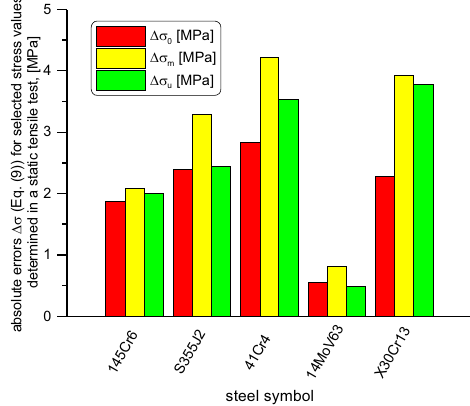
Figure 6: Comparison of the absolute errors Δ σ for selected stress values determined in the static tensile test using equation ( 9 )